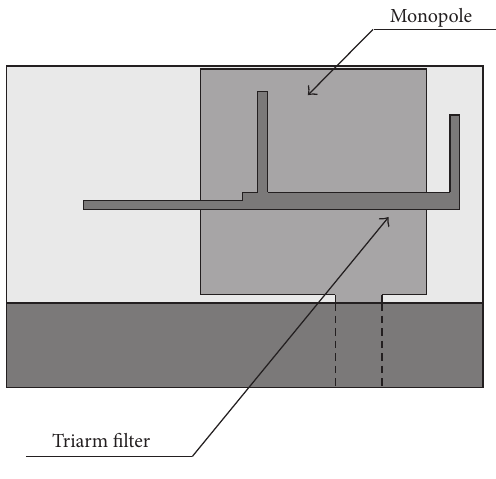
Figure 56: Geometry of a compact low-profile UWB antenna equipped with a triarms resonator [66]. Dark gray upper metal face, medium gray bottom metal face, and light gray dielectric substrate.